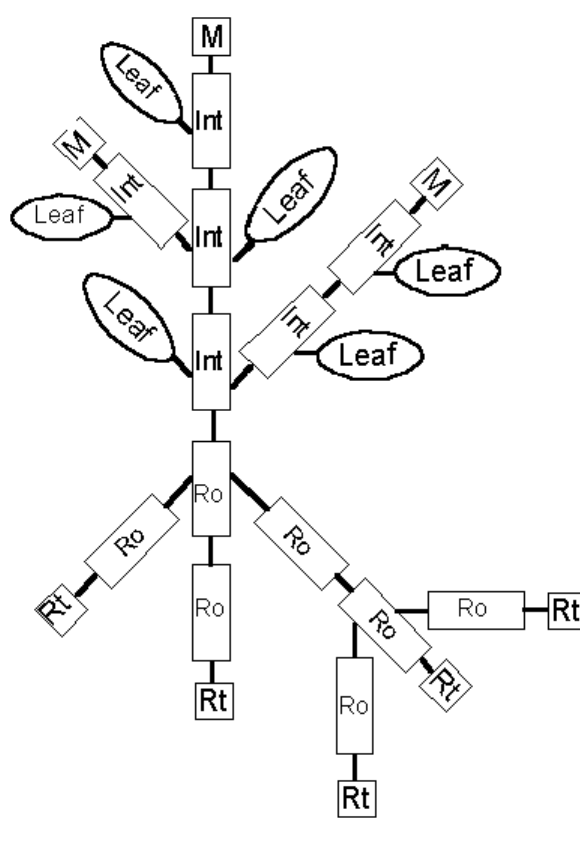
FIGURE 6. Modules in the black alder ( Alnus glutinosa ) Almis model. Each module (internode, leaf, meristem, root, roottop) runs its own processes, such as assimilation, transport, growth, and start of new modules. The shape of the whole plant emerges context- specific as a result of the module